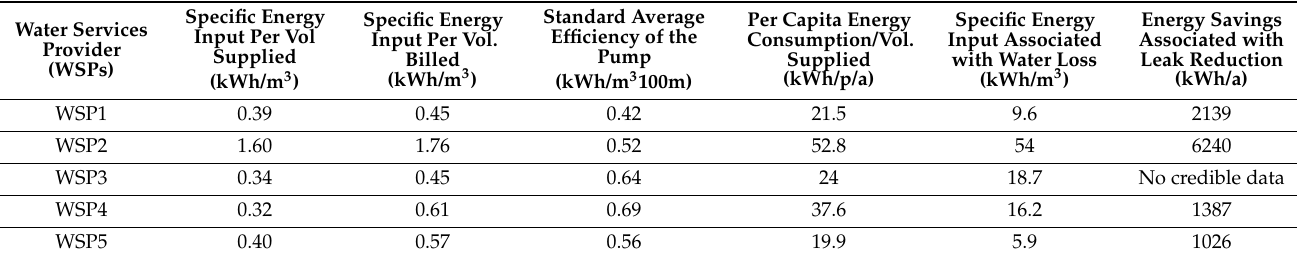
Table 7. Specific energy input for water production, the standard efficiency of pumps and the energy input associated with water loss for the five WSPs in